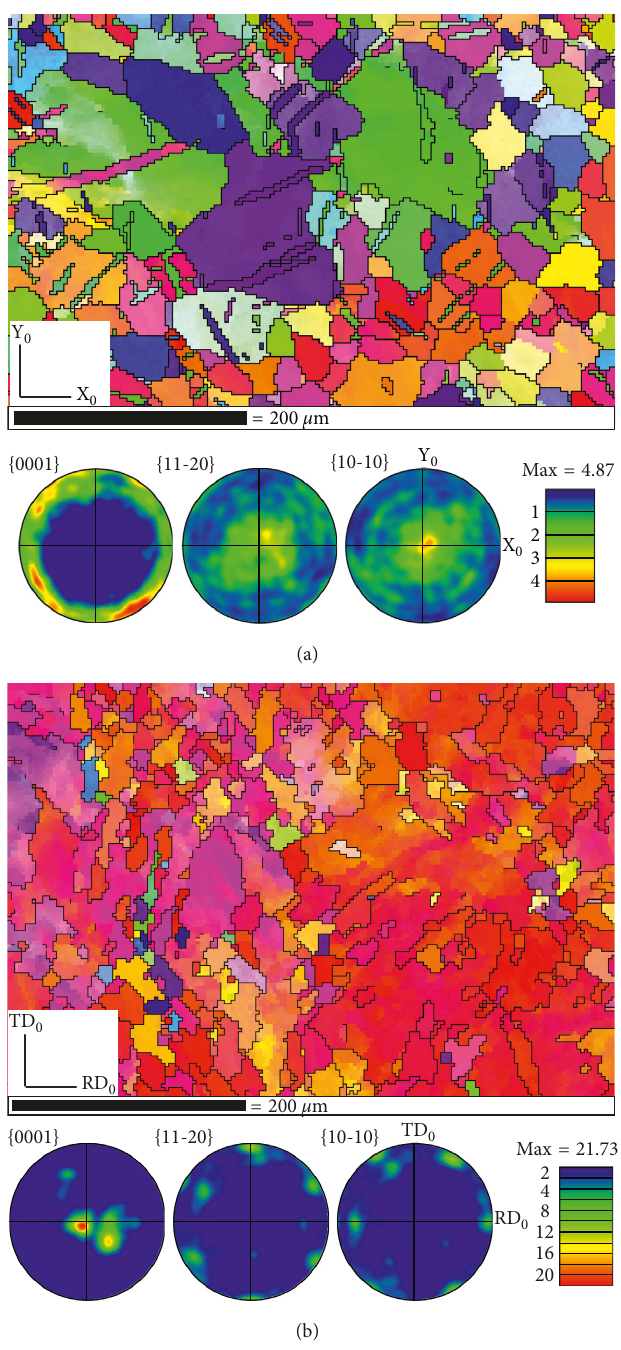
Figure 4: EBSD inverse pole figure (IPF) maps (top) and pole figures (bottom) showing microstructure and texture of the (a) cylindrical extruded bar and (b) rolled plate of the pure magnesium. The IPF maps reflect the orientations of the bar’s extrusion direction (ED 0 ) and rolled plate’s normal direction (ND 0 ) with respect to the local crystal frames. The measured pole figures show the initial texture of the processed (extruded and rolled) material. The reference frames (X 0 , Y 0 , ED 0 ) and (RD 0 , TD 0 , ND 0 ) are the same as in Figure